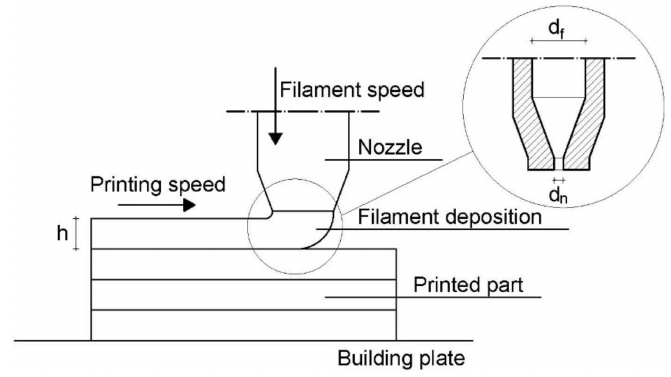
Figure 10. Schematic representation of the filament deposition process and detail of the